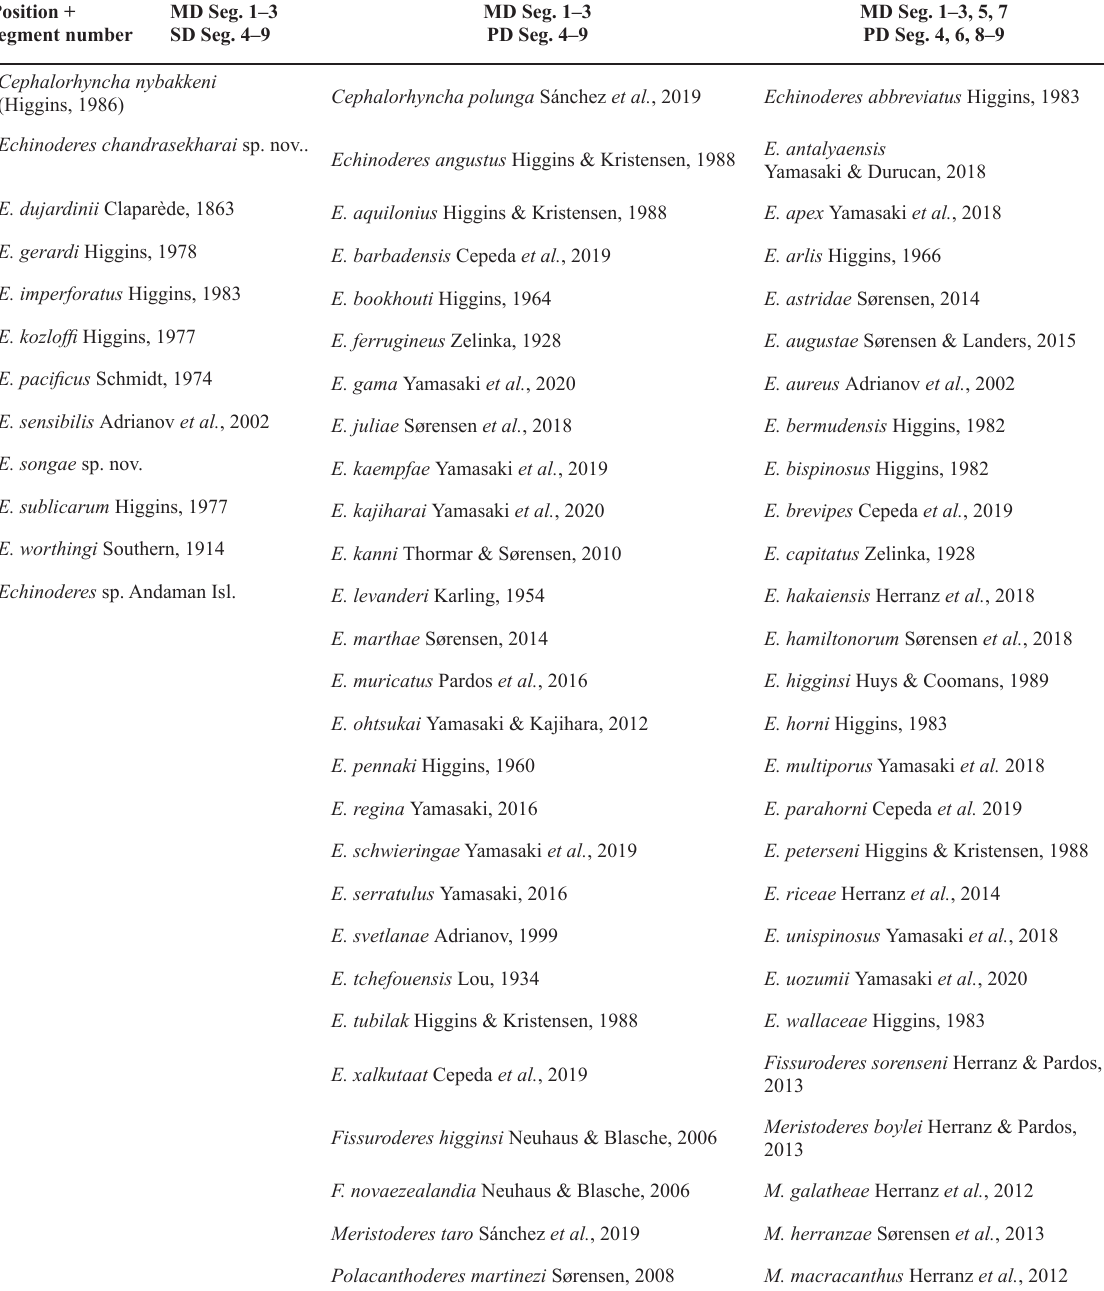
Table 21. The three most common echinoderid dorsal patterns of glandular cell outlets type 1 on segments 1 to 9. Literature sources: Higgins 1982, 1983; Higgins & Kristensen 1988; Huys & Coomans 1989; Adrianov & Malakhov 1999; Adrianov et al ., 2002a; Neuhaus & Blasche 2006; Sørensen 2008, 2014, 2018; Thormar & Sørensen 2010; Herranz et al. 2012, 2014, 2018; Sørensen et al. 2012, 2013, 2016, 2018; Yamasaki & Kajihara 2012; Herranz & Pardos 2013; Sørensen & Landers 2014; Pardos et al. 2016b; Yamasaki 2016; Yamasaki & Durucan, 2018; Yamasaki et al. 2018a, 2018b, 2019, 2020b; Cepeda et al . 2019b, 2019c; Grzelak & Sørensen 2019; Sánchez et al . 2019; Yamasaki & Dal Zotto 2019; present